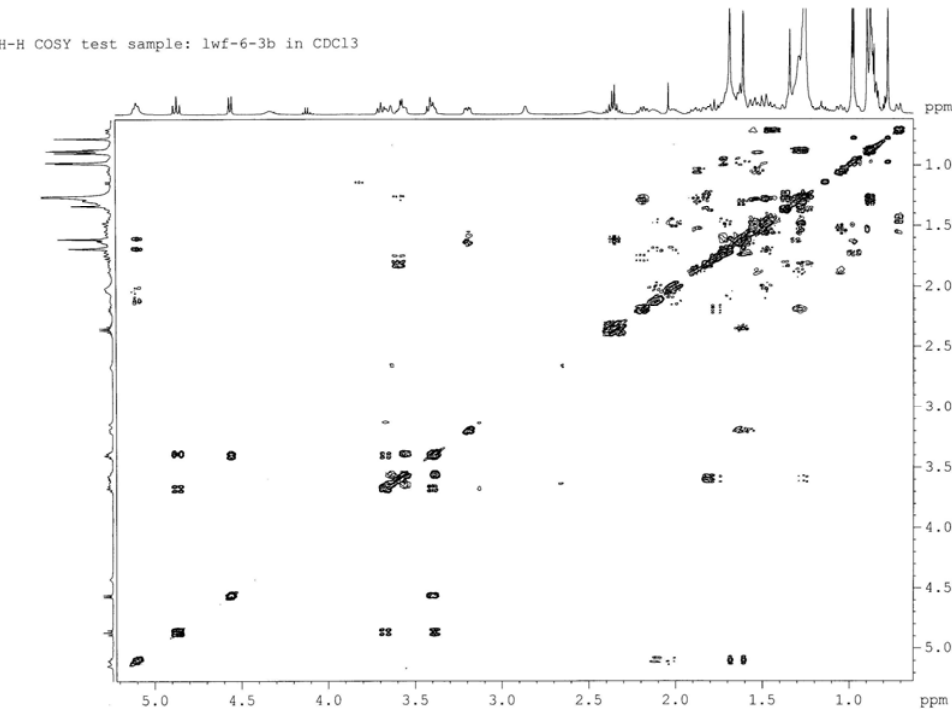
Figure 4. 1 H- 1 H COSY spectrum of 2B .